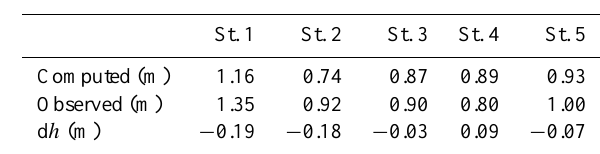
Table 1. Comparison between computed and observed peak inun- dation depth in calculation area in case of